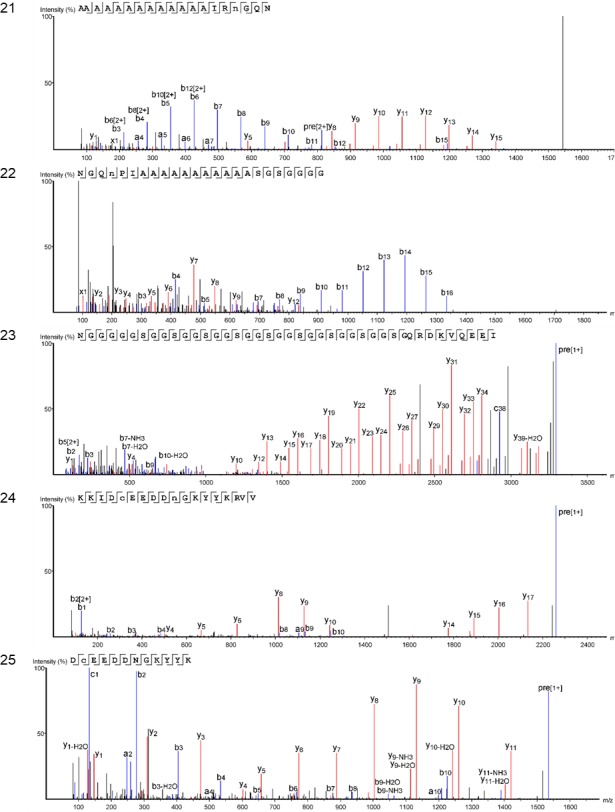
Product ion spectra [21 - 25] supporting the coverage of protein Hic74 identified in Unio pictorum.